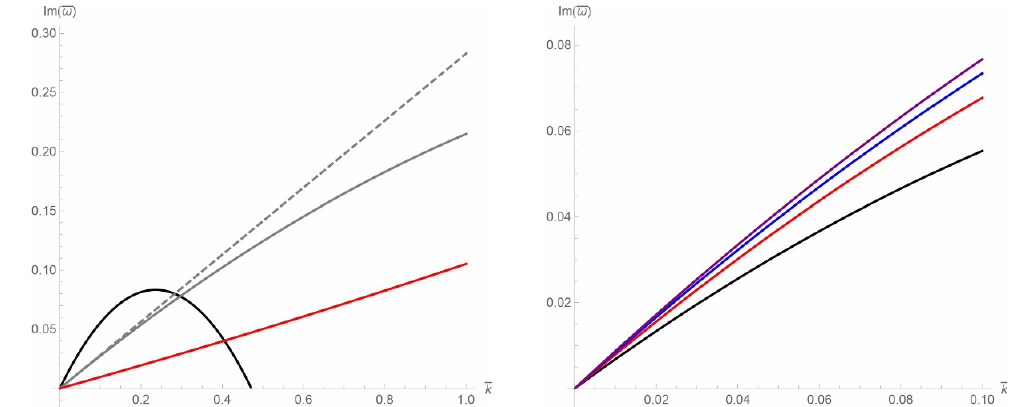
Figure 2 . On the left we show the dimensionless imaginary part of ! 3 , de(cid:12)ned as (cid:22) ! = Im ! 3 r 0 , as p a function of (cid:22) k = kr 0 = n for D = 5 ( n = 1). The black solid line represents (cid:12) = 0, the grey solid p line (cid:12) = 1 = 2 and the red solid line (cid:12) = 9 = 10 while the grey dashed line is the imaginary part